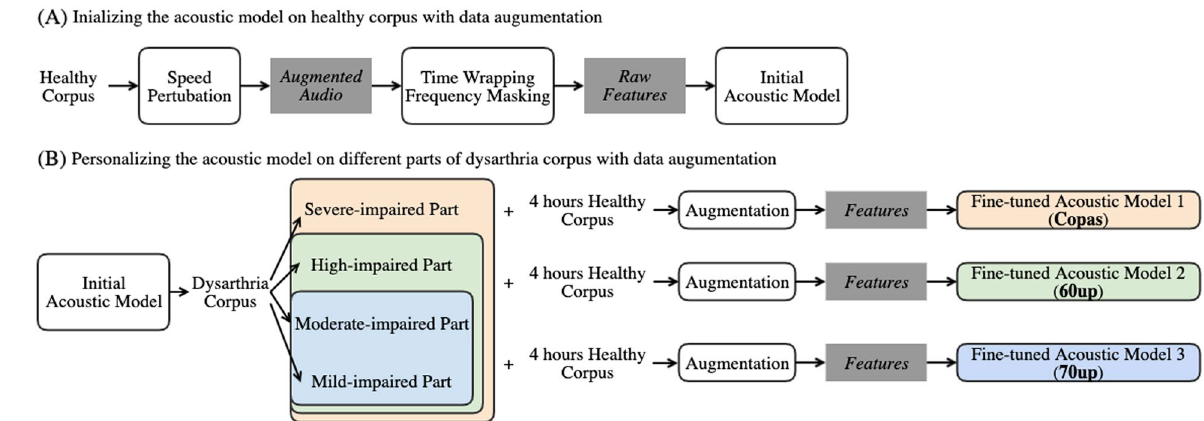
Fig. 5 The two-stage pre-training acoustic